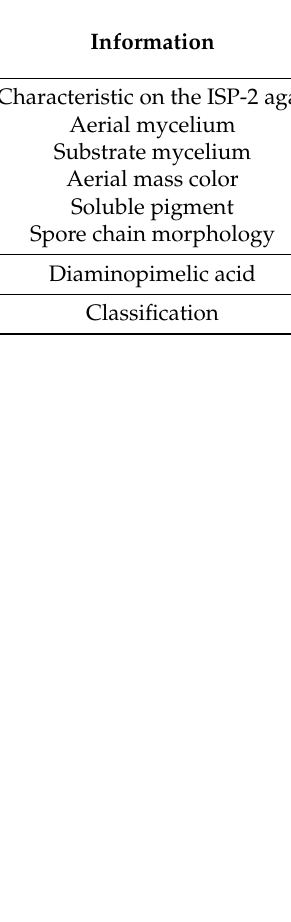
Table 2. Isolation source and characteristics of the obtained actinobacteria in this study.